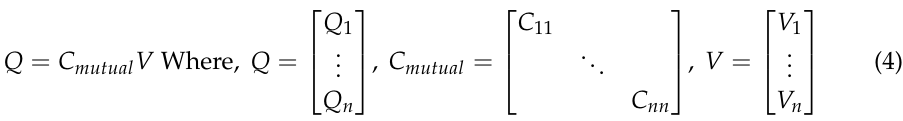
Figure 5. The variation of charge ratio with insulation thickness for different area ratio Ra. The four different size XS anodes have the same period of 690 μ m and top strip width w1 of 253 μ m, and the bottom strip width w2 is 350 μ m, 400 μ m, 450 μ m, and 500 μ m, respectively.